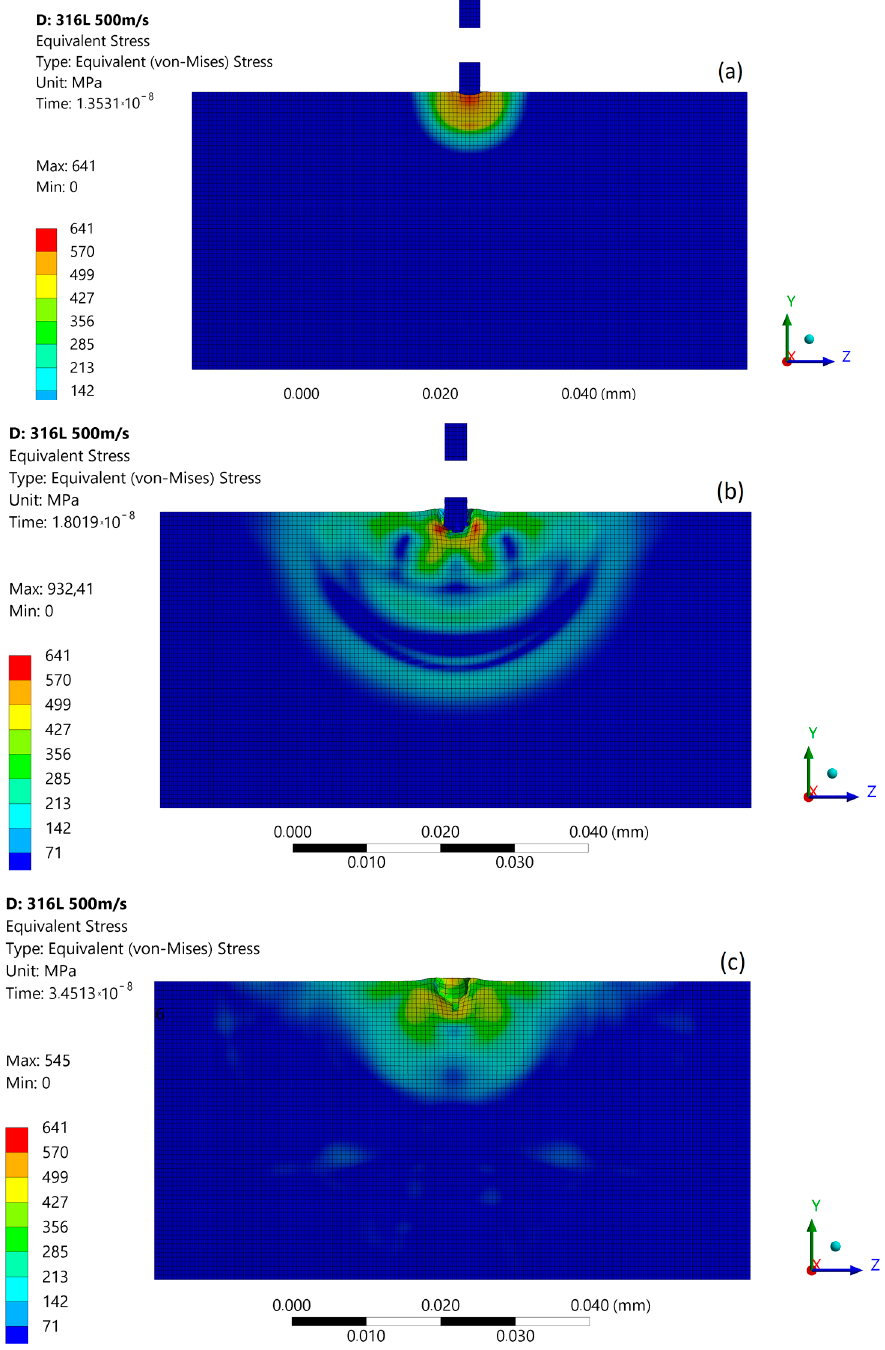
Figure 12. Von Mises stress distribution during first micro-jet impact at 500 m/s: ( a ) initial stage of the impact; ( b ) stage during the impact; ( c ) residual stress after the impact.